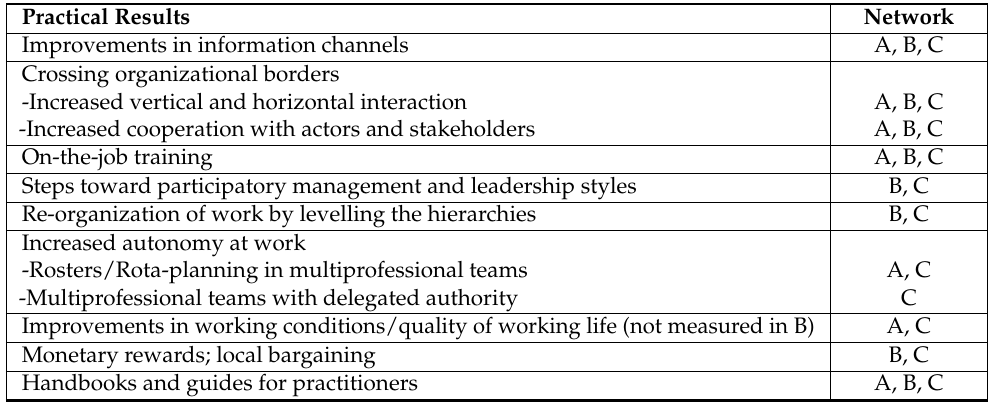
Table 2. The practical results of the